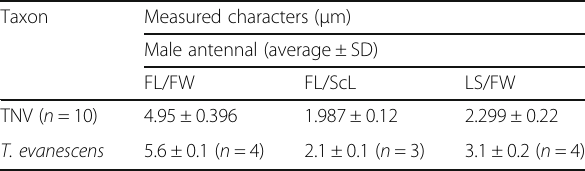
Table 3 Measured characters ( μ m) of strain TNV and T.